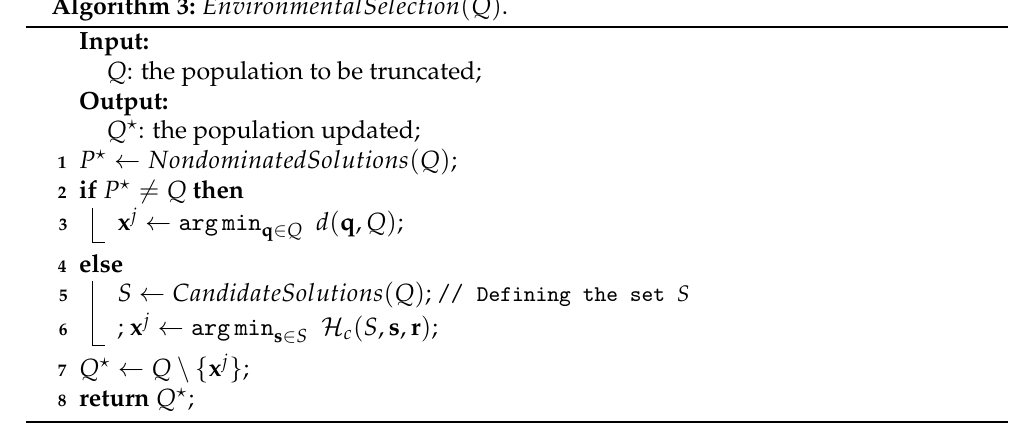
Algorithm 3: EnvironmentalSelection ( Q )